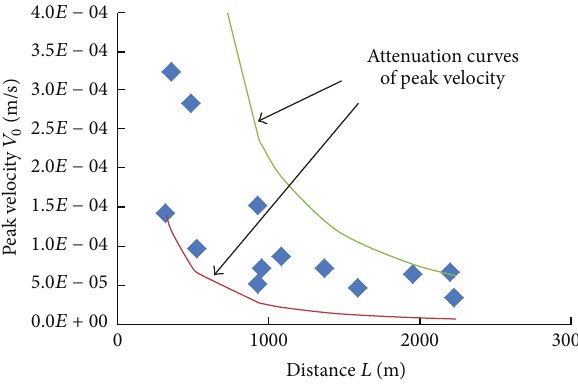
Figure 7: Back calculation of particle peak vibration velocity